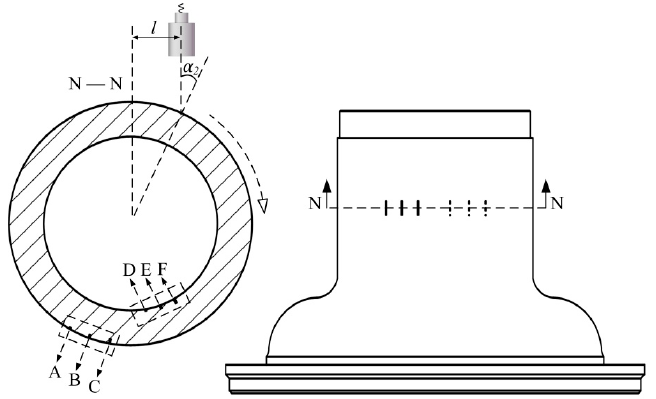
Figure 10. Distribution of longitudinal cracks.